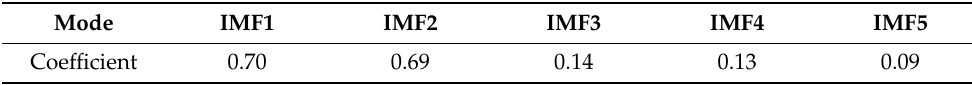
Table 4. Coefficients under IEMD decomposition.